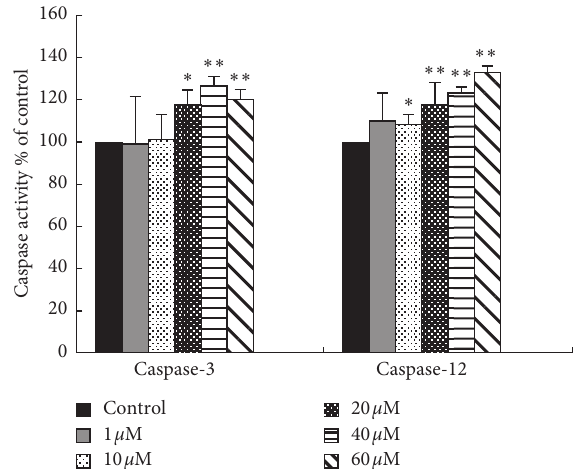
Figure 4: Effect of NP on the activities of caspases-3 and caspase-12. Results are presented as mean ± SD with triplicate measurement. ∗ P < 0 . 05, ∗∗ P < 0 . 01 versus control group.